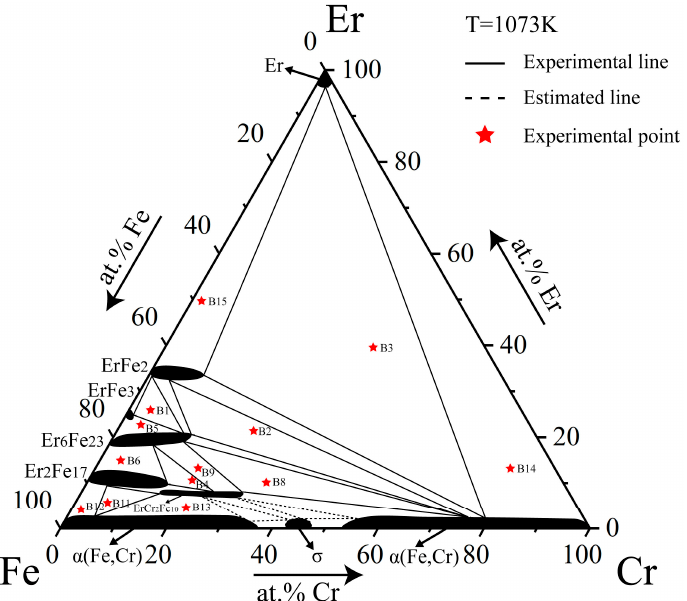
Figure 6. Isothermal section of the Fe–Cr–Er ternary system at 1073 K obtained in this work.